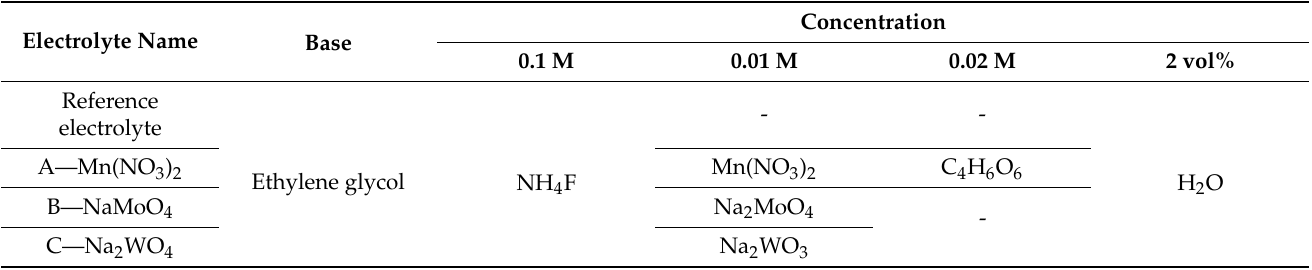
Table 1. Composition of tested electrolytes.